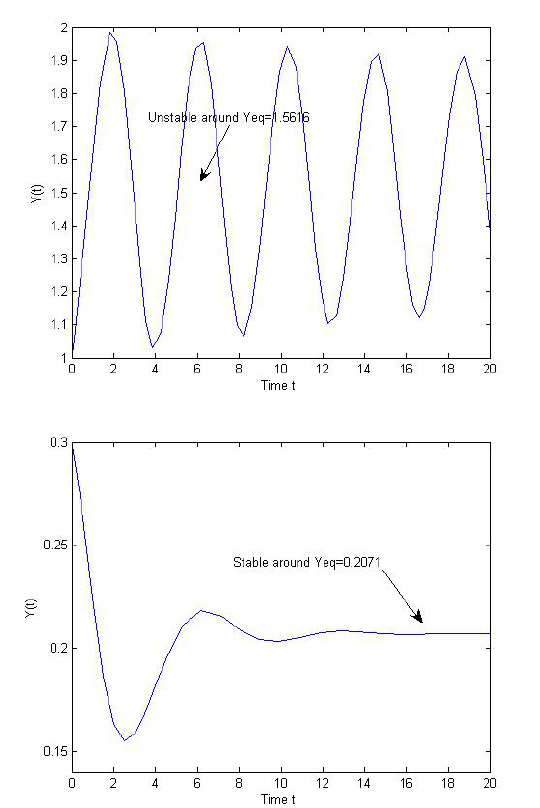
Fig. 3. For µ = 2 and τ = 0 . 9 the equilibrium is unstable, top graph. For µ = 0 . 2 and τ = 1 the equilibrium is stable, bottom